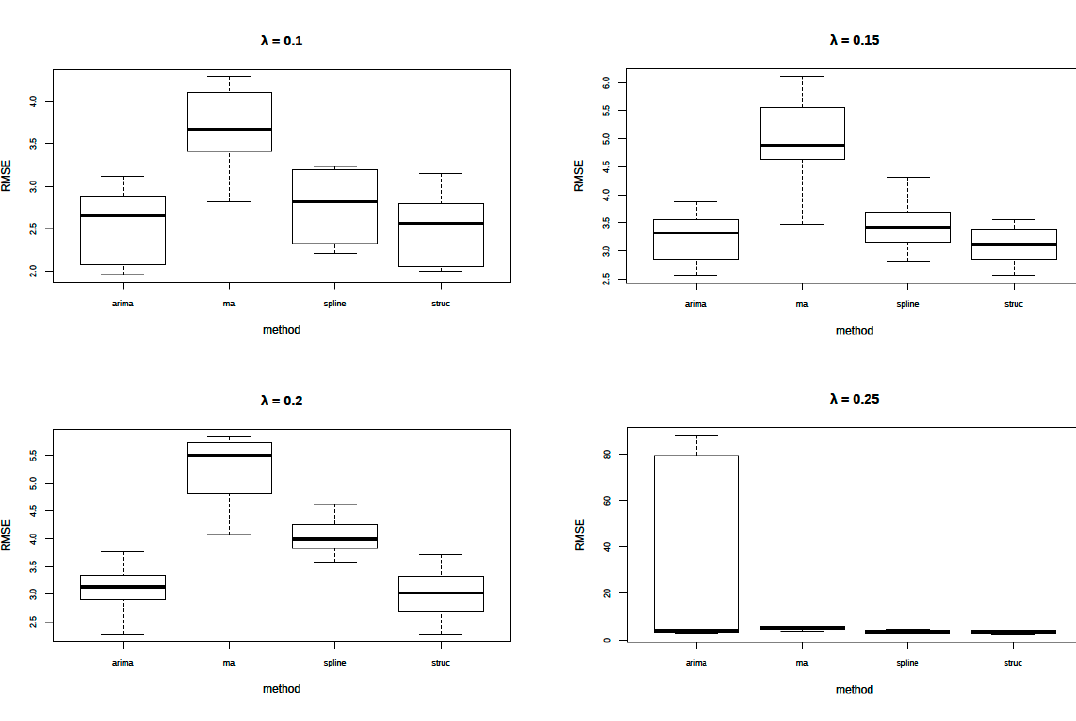
Figure 7. Distribution of data imputation errors.